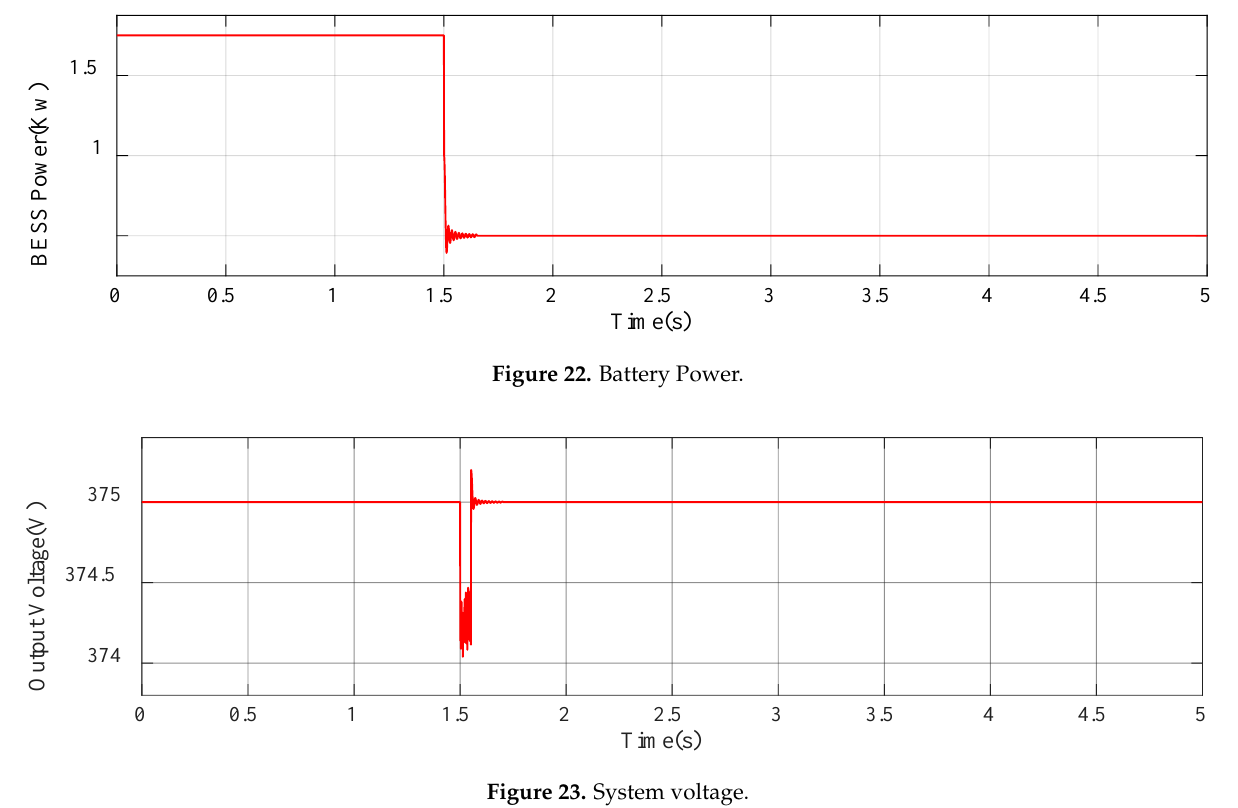
Figure 21. PV Power.